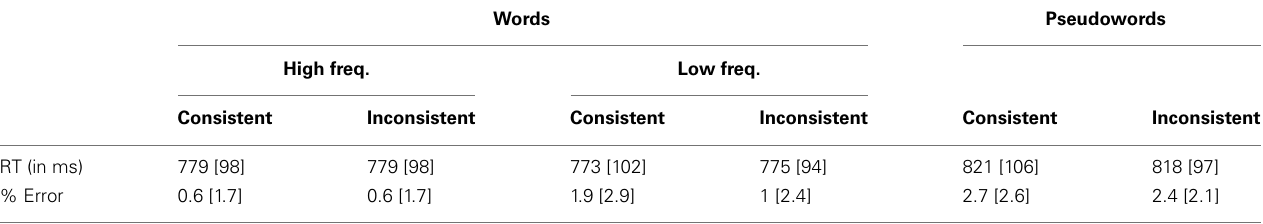
Table 1 | Mean raw RTs for correct responses and error rates (SD in brackets) observed in the silent condition.